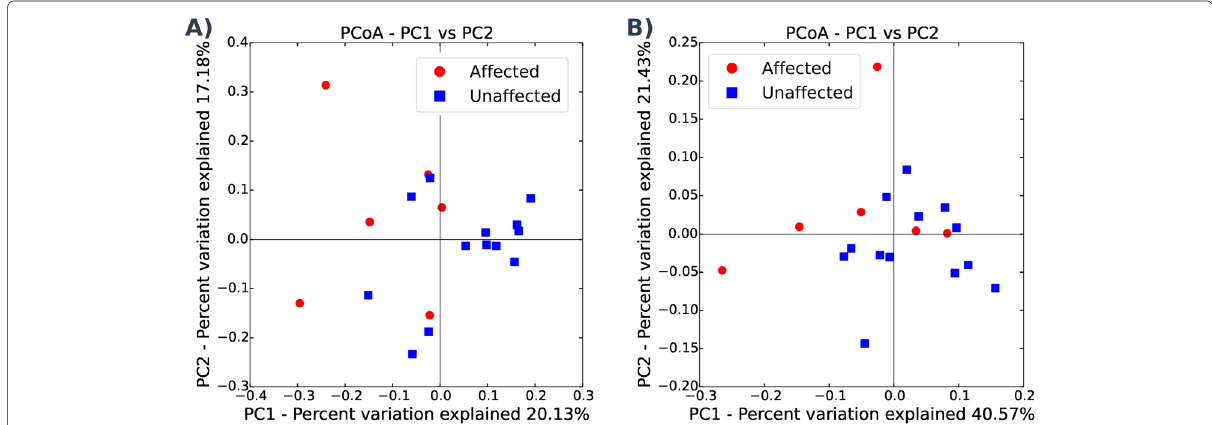
Fig. 2 Unweighted and weighted beta diversity plots Disease status had a significant effect on unweighted ( a ) and weighted ( b ) beta diversity. The PCoA plots show some clustering of affected and unaffected samples although the low sample number makes interpretation of this clustering